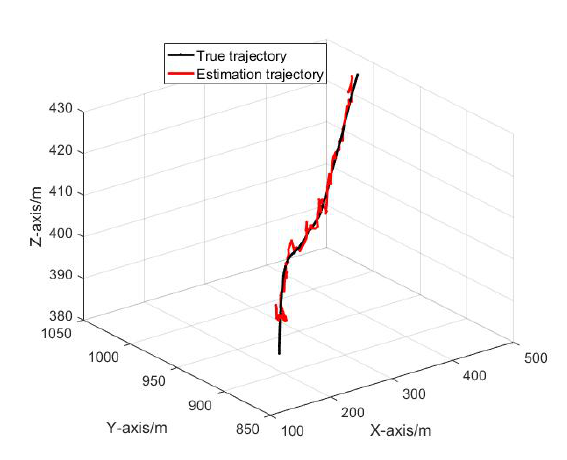
Figure 10. The trajectory of one mobile node in the